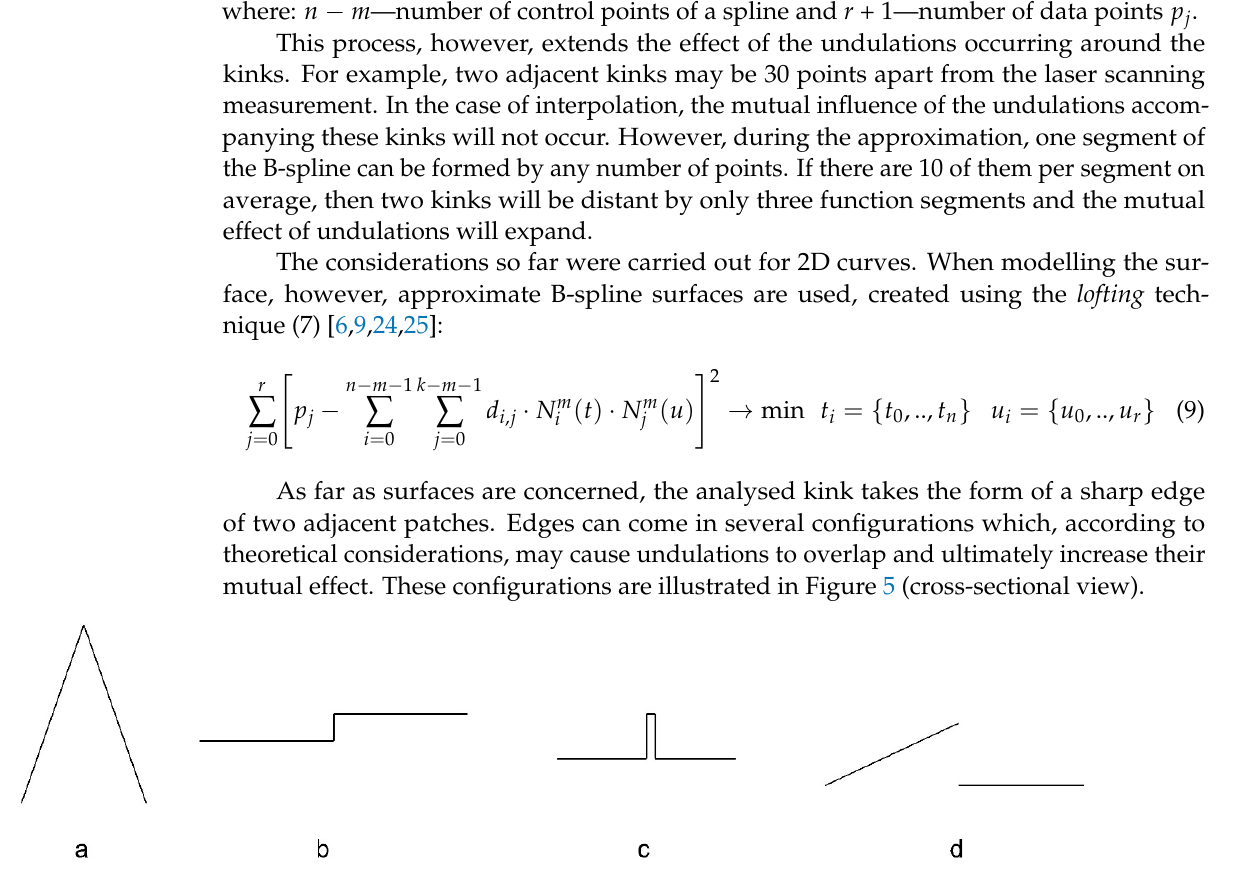
Figure 5. Configurations of surface edges (cross-sectional view—kink points correspond to the sharp edges): ( a ) single edge separating patches; ( b ) closely adjacent two edges; ( c ) closely adjacent four edges; ( d ) two edges with a gap (unspecified connection)—cracks and displacements.